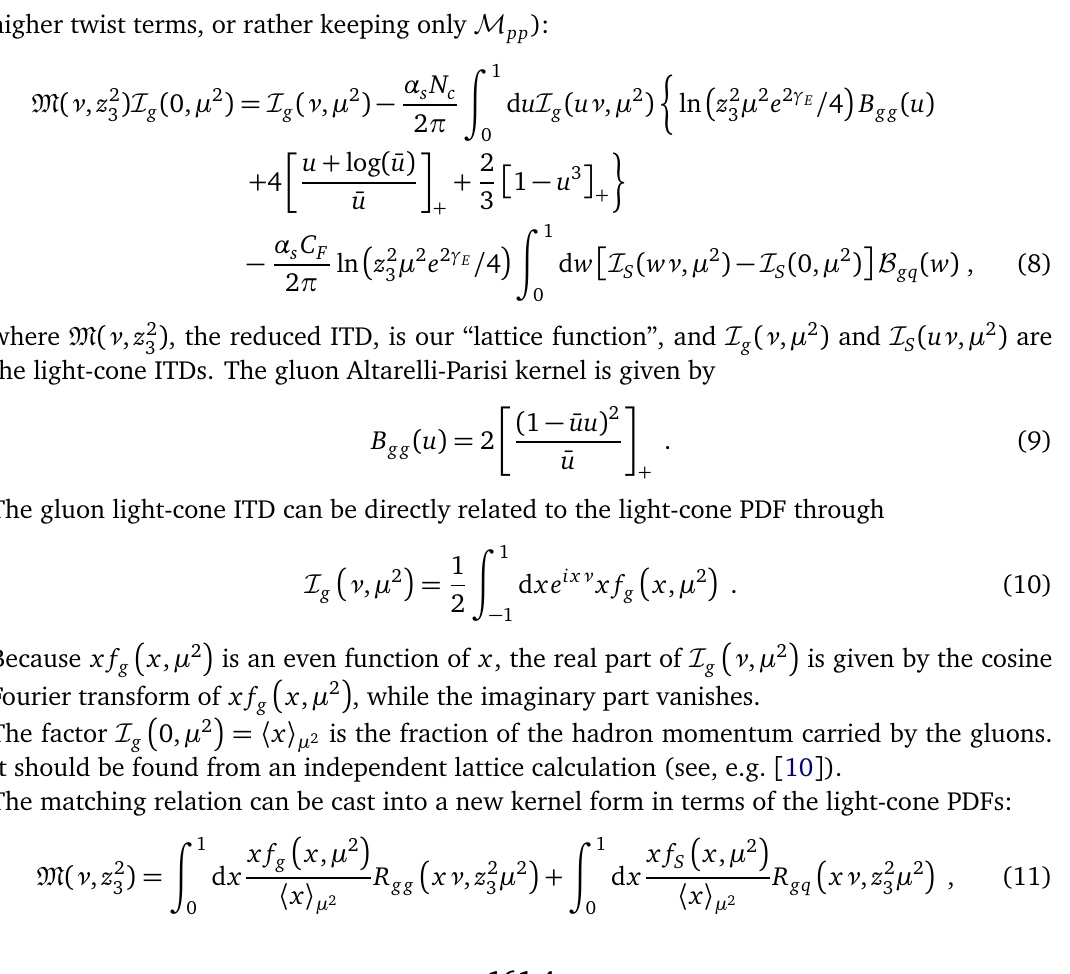
Figure 3: Gluon-quark mixing